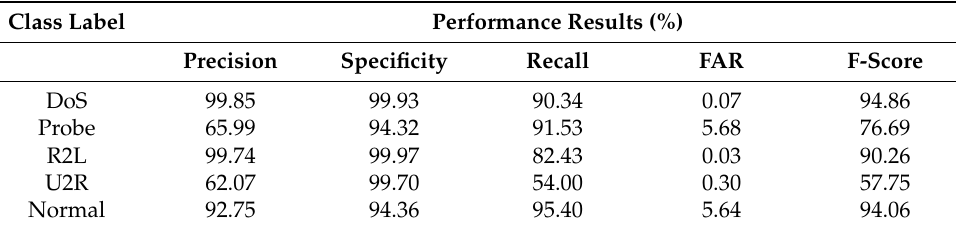
Table 9. BidLSTM performance on NSL-KDDTest + using all 41 features.